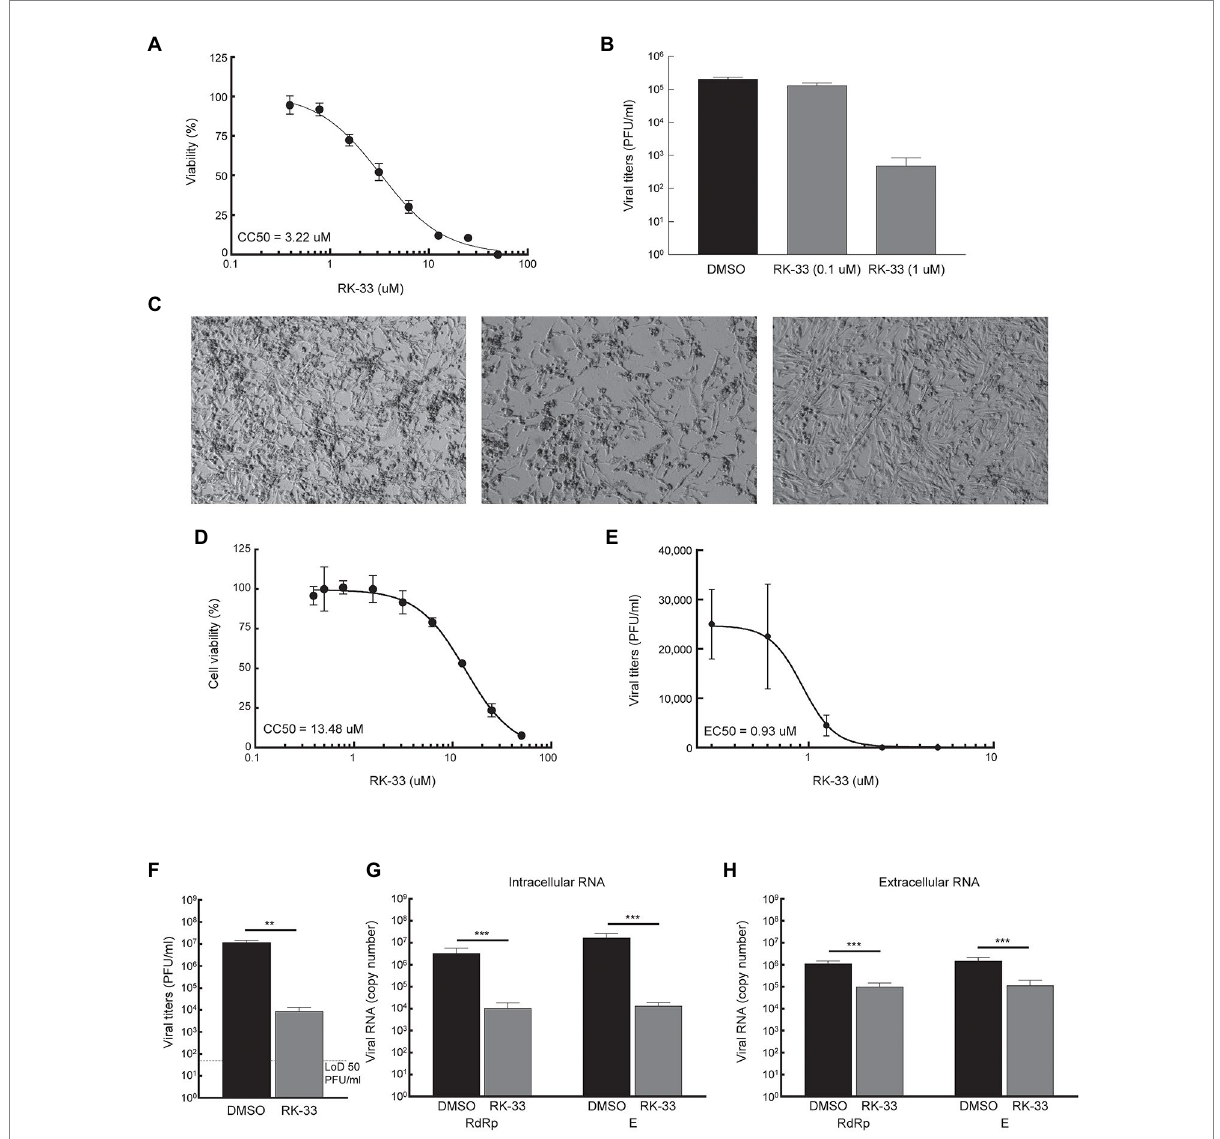
FIGURE 3 RK-33 decreases production of hCoV-OC43 and SARS-CoV-2. (A) RD cells were treated with various concentrations of RK-33 and cell viability determined post-treatment using CellTiter Glo assay. (B) RD cells were treated with RK-33 for 1 h followed by infection with hCoV-OC43 (MOI 0.1) and infectious titers at 3 dpi were determined via plaque assay. (C) RD cells were treated with RK-33 for 1 h followed by infection with hCoV-OC43 (MOI 0.1). CPE was observed at 4 dpi. (D) Calu-3 cells were treated with various concentrations of RK-33 and cell viability determined using CellTiter Glo assay. (E) Calu-3 cells were treated with various concentrations of RK-33 for 24 h followed by infection with SARS-CoV-2 Washington Variant (Lineage A; MOI 0.1) in the presence of RK-33. Cells were also post-treated with RK-33. Supernatants were collected at 48 hpi and plaque assays performed to determine infectious titers. DMSO was included as a negative control. (F) Calu-3 cells were treated with RK-33 (5 μ M) or DMSO as described in panel E and viral titers determined by plaque assay. (G,H) Intra and extra cellular SARS-CoV-2 RNA viral copy numbers as measured by RT-qPCR of RdRp and E genes. Data represents the average of 3 biological replicates and error bars display standard deviations. * p < 0.05, ** p < 0.005, *** p <